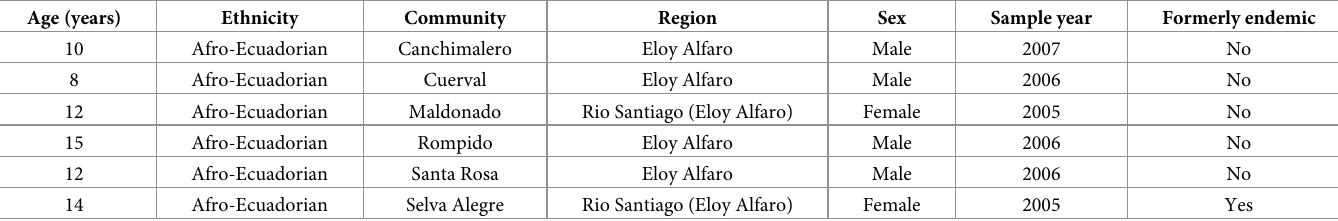
Table 2. Characteristics of seroreactive individuals using the confirmatory rapid test (DPP Syphilis Screen and Confirm). Age (years) Ethnicity